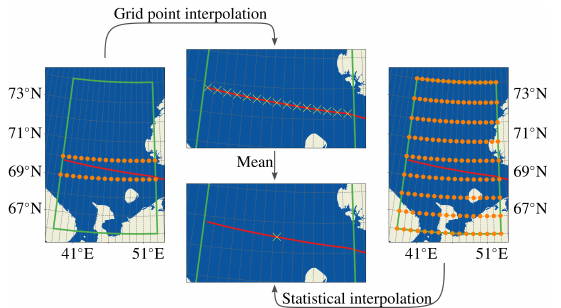
Figure 2. The grid point and statistical interpolations in sub-region No.